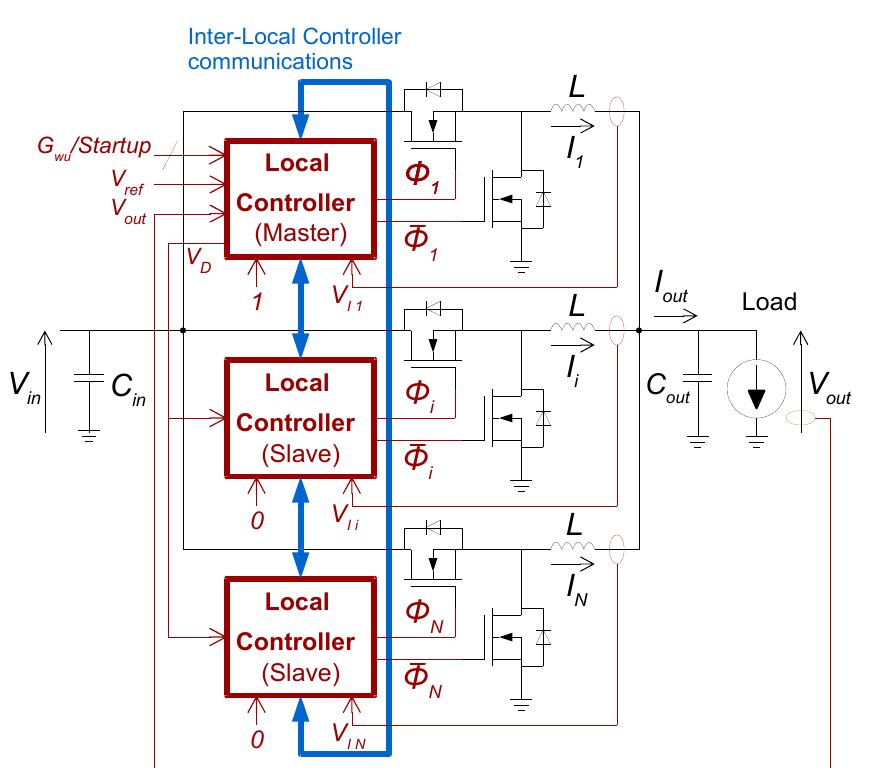
Figure 1. Decentralized phase-shedding control method using Local Controllers (LC) and daisy-chain inter-LC communications ( V Ii : the local current sensor output signal; V ref : the reference voltage; V D : the error-amplifier output voltage; V out : the load voltage to regulate; G WU / Startup : two bits to handle heavy-load events). The status of the Local Controller is performed thanks to an input bit set to 1 (Master) or 0 (Slave).